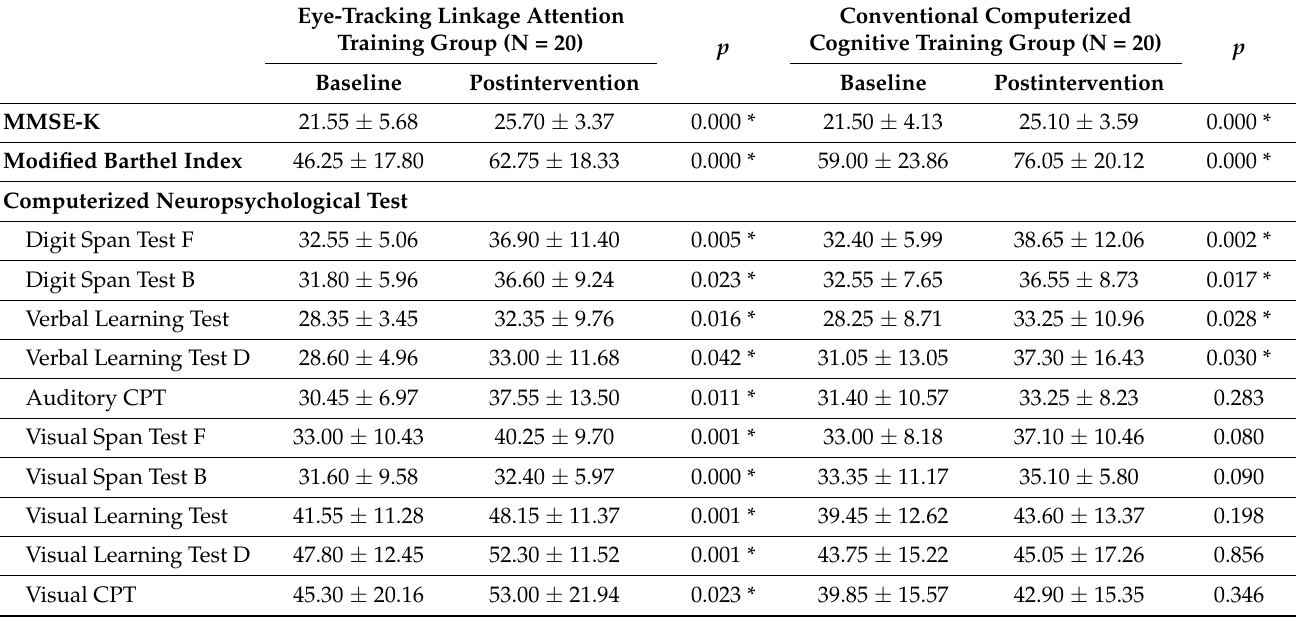
Table 3. The neurophysiological performance between before (baseline) and immediately after intervention (postintervention) in an eye-tracking linkage attention training group and a conventional computerized cognitive training